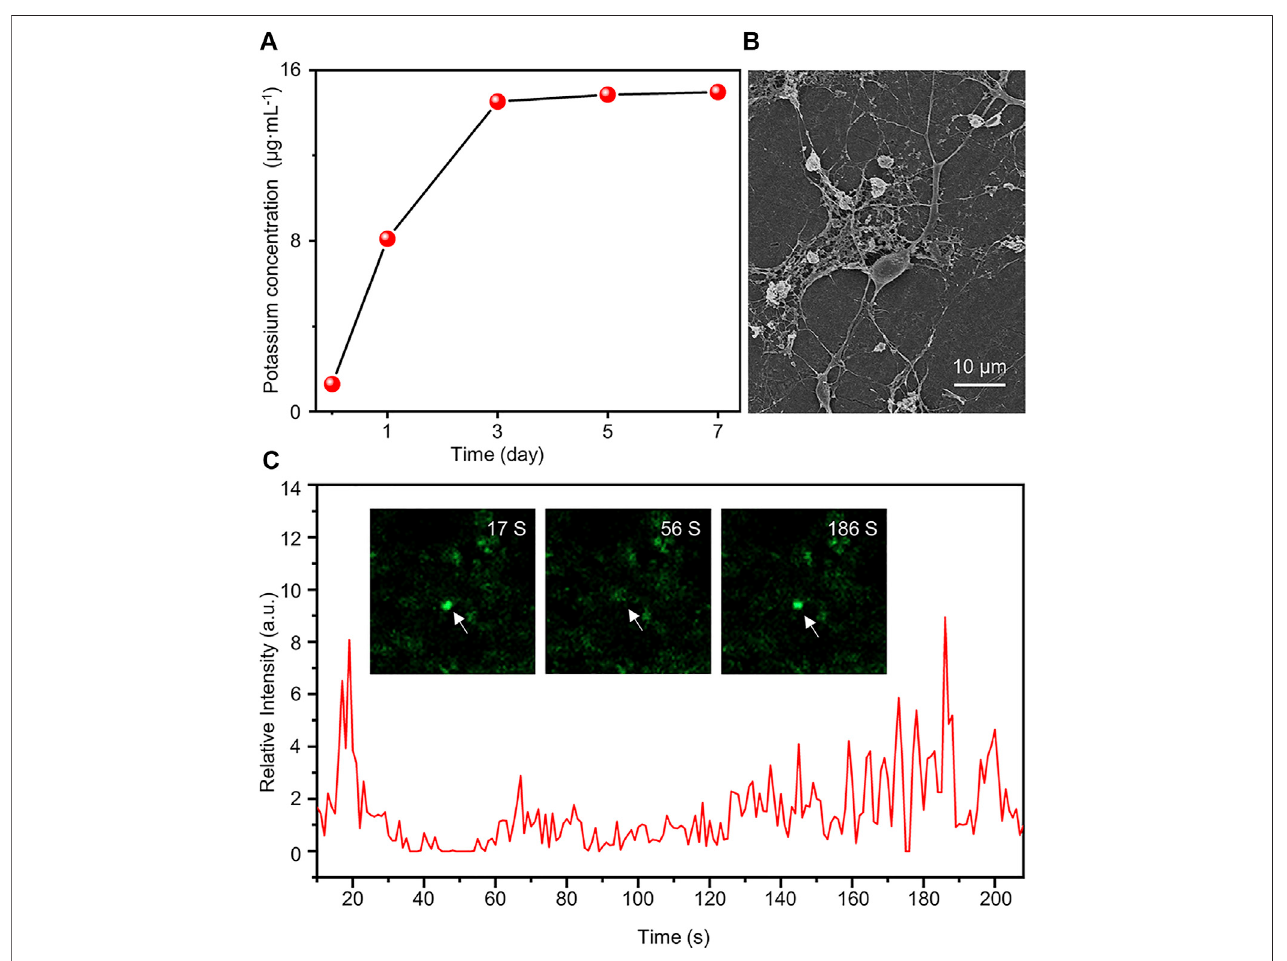
FIGURE 7 | Functional assessment of differentiated cells induced by K 2 Ti 6 O 13 -TiO 2 hybrid nanorod arrays. (A) Concentration of K + in deionized water under differentK 2 Ti 6 O 13 -TiO 2 hybridnanorodarrayimmersiontimes. (B) SEMimageofNSCsafterculturingonK 2 Ti 6 O 13 -TiO 2 hybridnanorodarraysfor7 days (C) Intracellular calcium imaging analysis of NSCs incubated on K 2 Ti 6 O 13 -TiO 2 hybrid nanorod arrays Insert images are differentiated NSCs cultured on K 2 Ti 6 O 13 -TiO 2 hybrid nanorod arrays combined with the calcium ion probe fl uorescence intensity. The arrow indicates the cell in which the fl uorescence intensity changed.